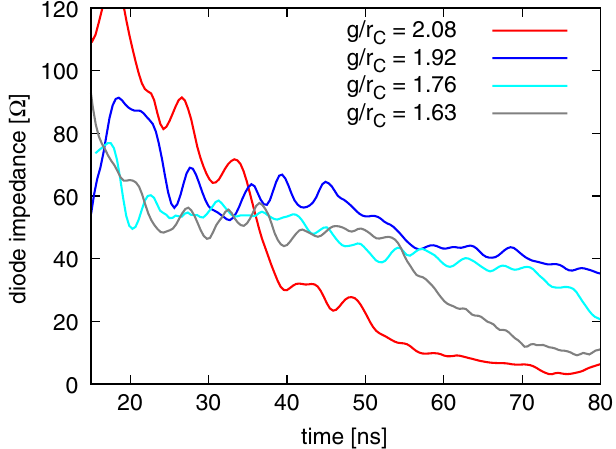
FIG. 2. The SMP diode impedance measured on RITS-6 for . four values of g=r C